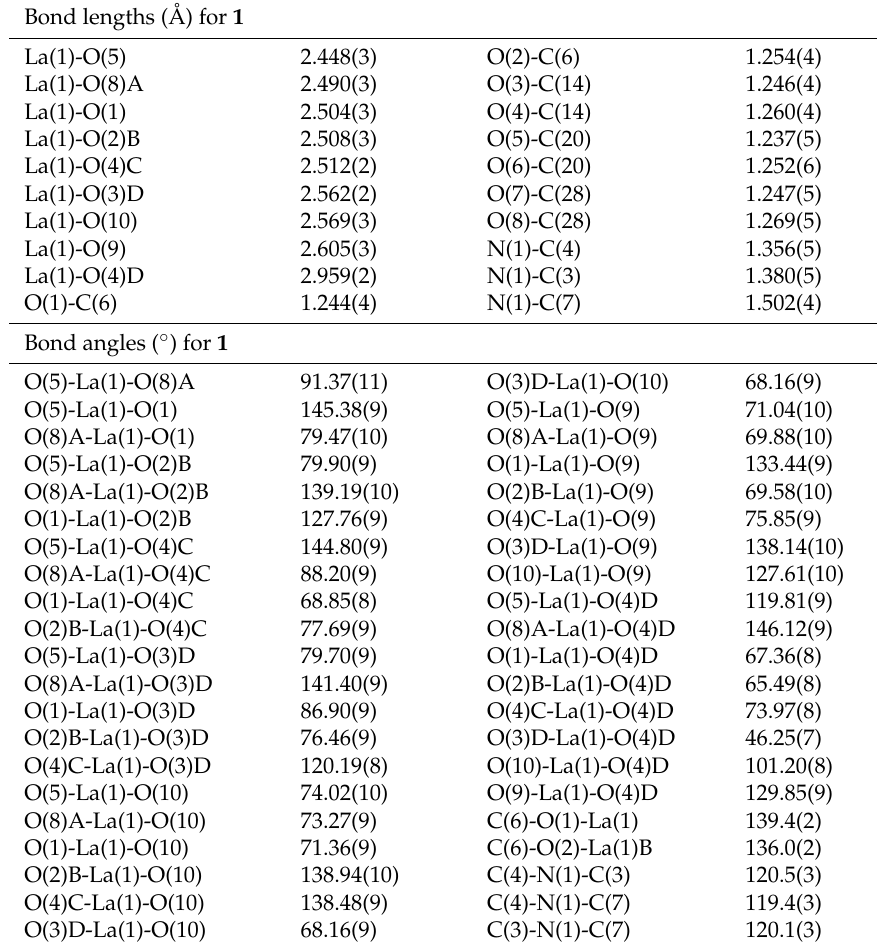
Table 2. Elected bond lengths (Å) and angles ( ◦ ) for compound 1